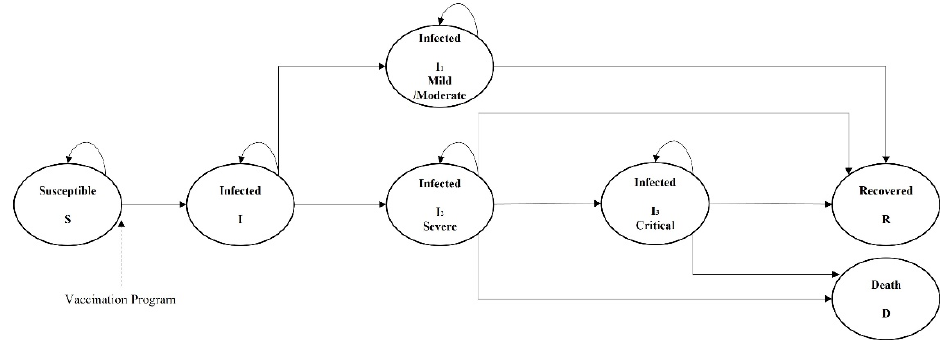
Figure 1. Markov model of COVID-19 disease progression.